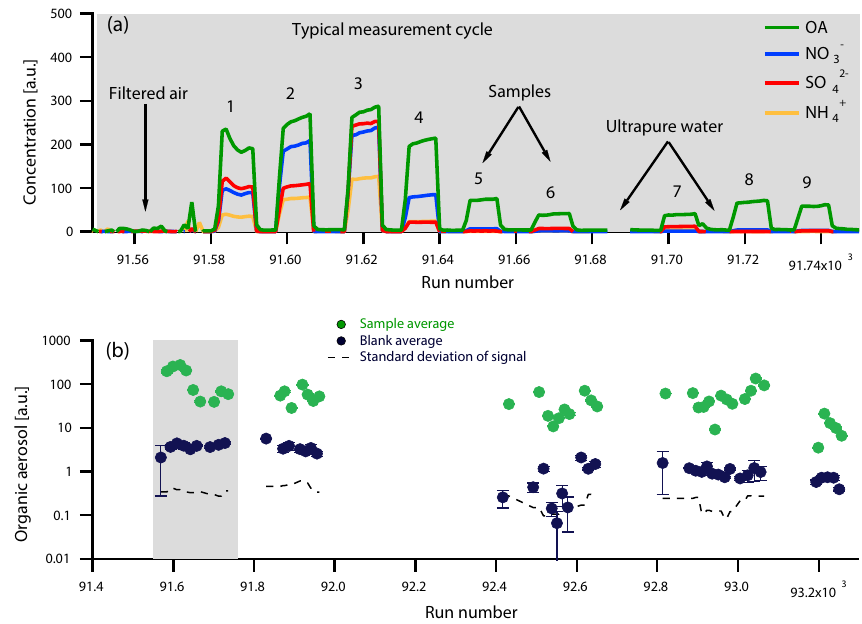
Figure 1. Data recorded with HR-ToF-AMS of filter samples collected in Zurich (2011–2012). Data from a typical measurement cycle are underlaid in gray. (a) Raw signals obtained for organic aerosol (OA, green), nitrate (NO − (NH + , orange), where AMS filter air as well as blank and sample measurements are indicated. (b) OA average signal for samples and blanks 4 (logarithmic scale), blank correction curve and the noise (smoothed standard deviation of the blank) associated with the signal of different species used for the calculation of errors. On the y axes, a.u. denotes arbitrary units.